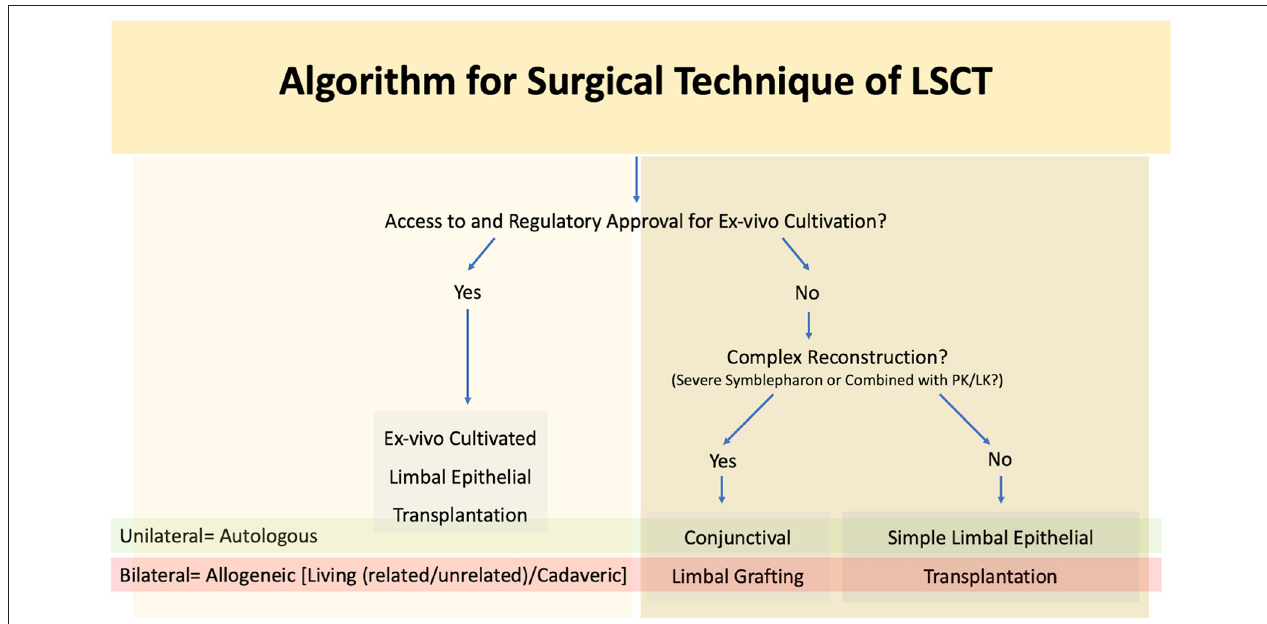
FIGURE 8 | Algorithm for surgical technique of limbal stem cell transplantation (LSCT) PK, penetrating keratoplasty; LK, lamellar